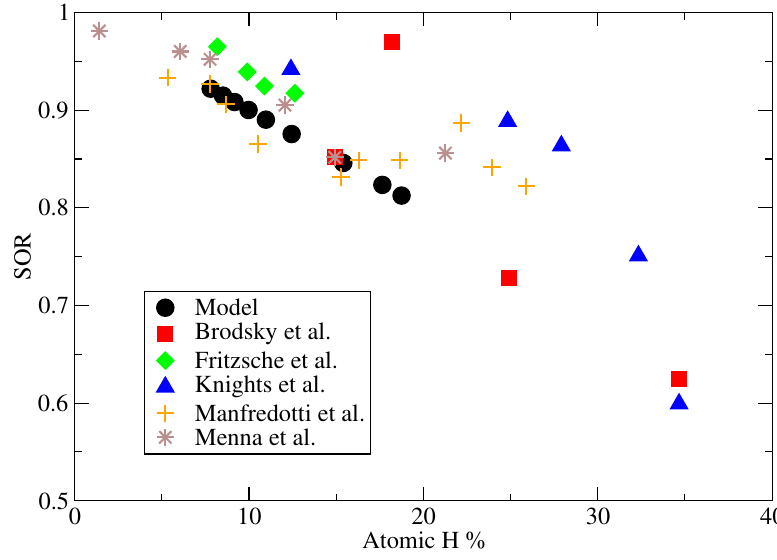
Figure 20. Relationship between film SOR and hydrogen